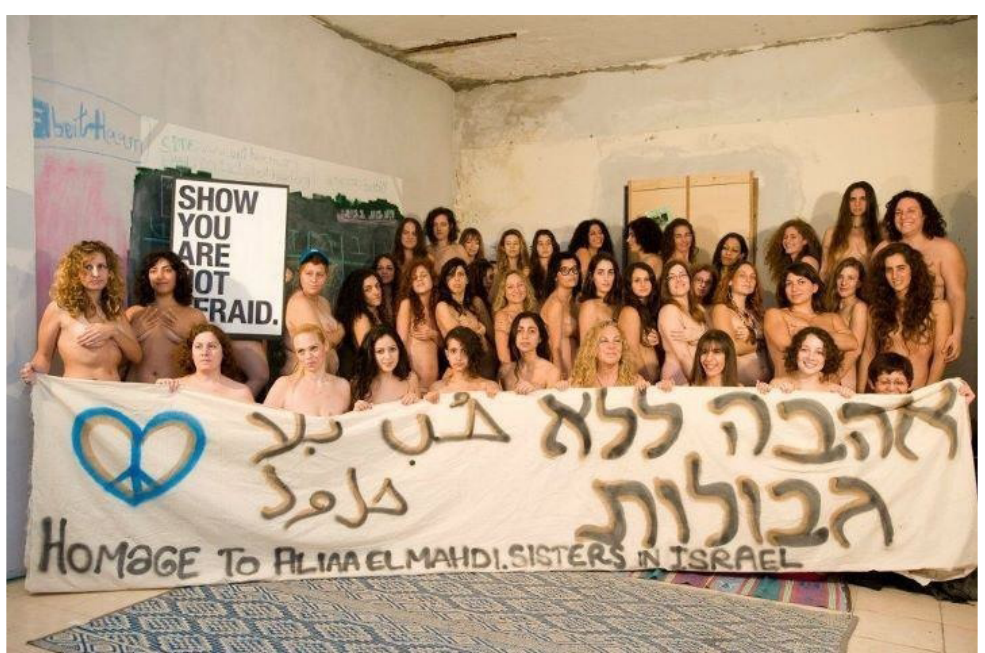
Figure 3. Israeli women posing nude “Love without Limits” and “Homage to Aliaa Elmahdy Sisters in Israel” (2011). her and divert her message. In effect, they used the same participatory tool and approach the supporters used to endorse Elmahdy in order to mock and reject her.